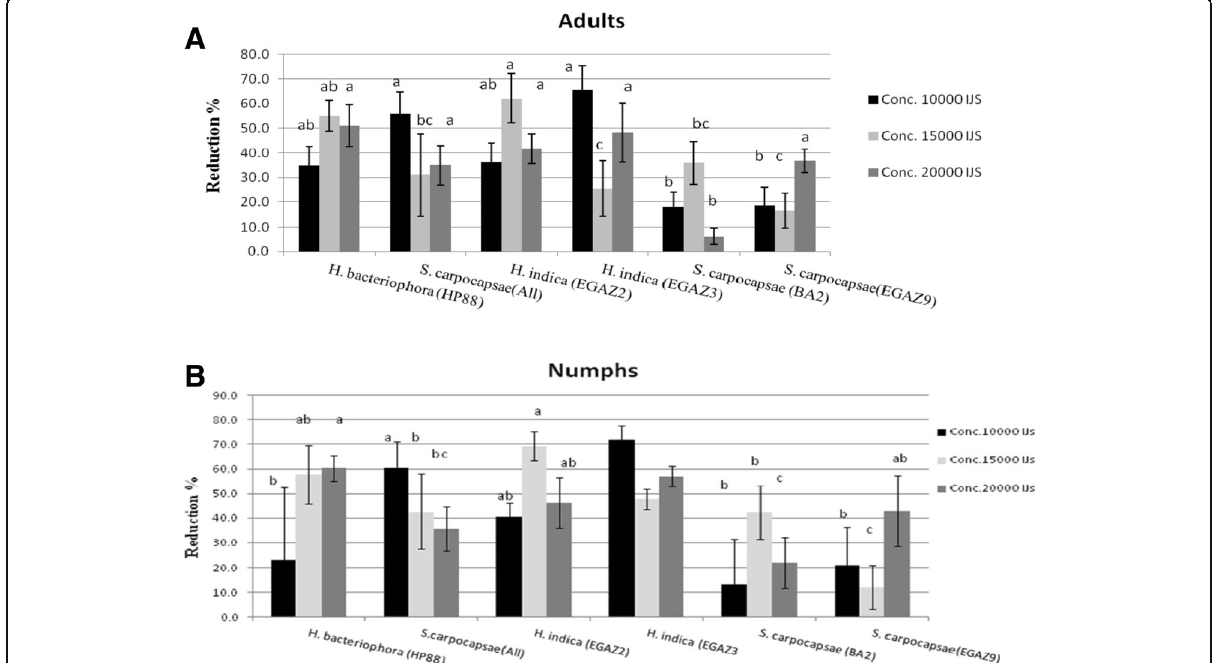
Fig. 1 Reduction percentage for different treated stages using the EPNs after 24 h at different concentrations: a for T. tabaci adults, b for T. tabaci nymphs. Columns annotated with the same letter are not significantly different ( P < 0.05)